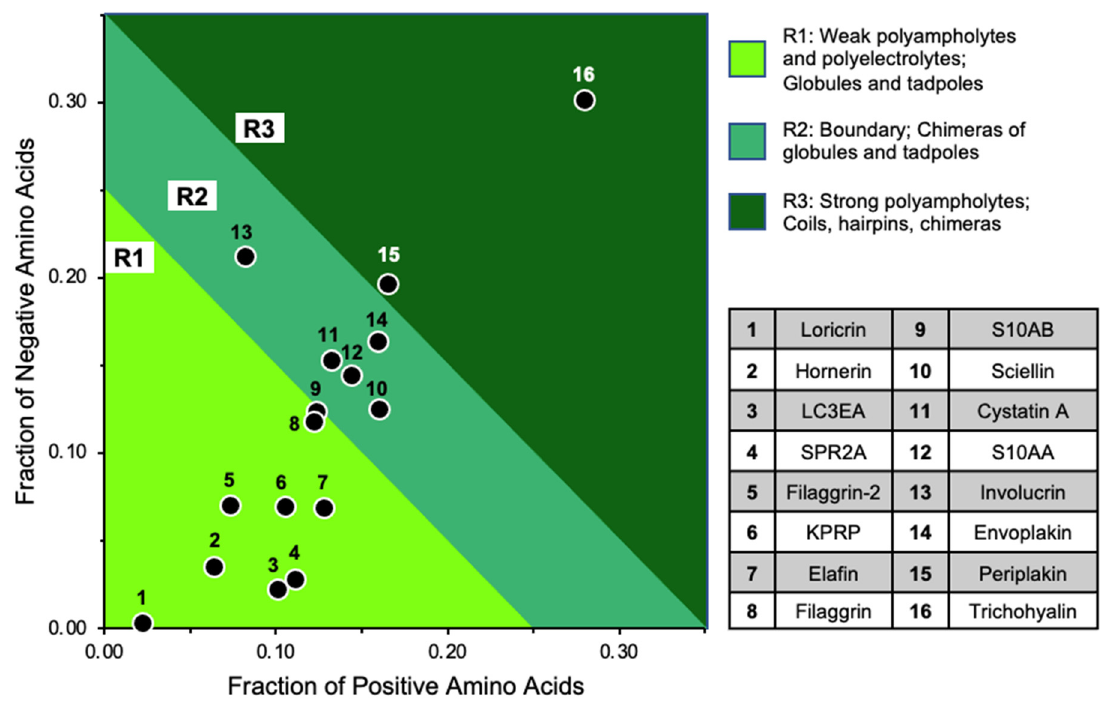
Figure 7. CIDER analysis of CE proteins. Das–Pappu diagram of states depicting proposed structural conformation for each protein based on the fraction of positive and negative charged residues. Plot regions and protein names in legends at right. Table 3. Classification of intrinsically disordered ensemble regions (CIDER) physicochemical char- acterization of CE proteins. Lengths vary greatly among CE components. Proteins sorted for increas- ing FCR.